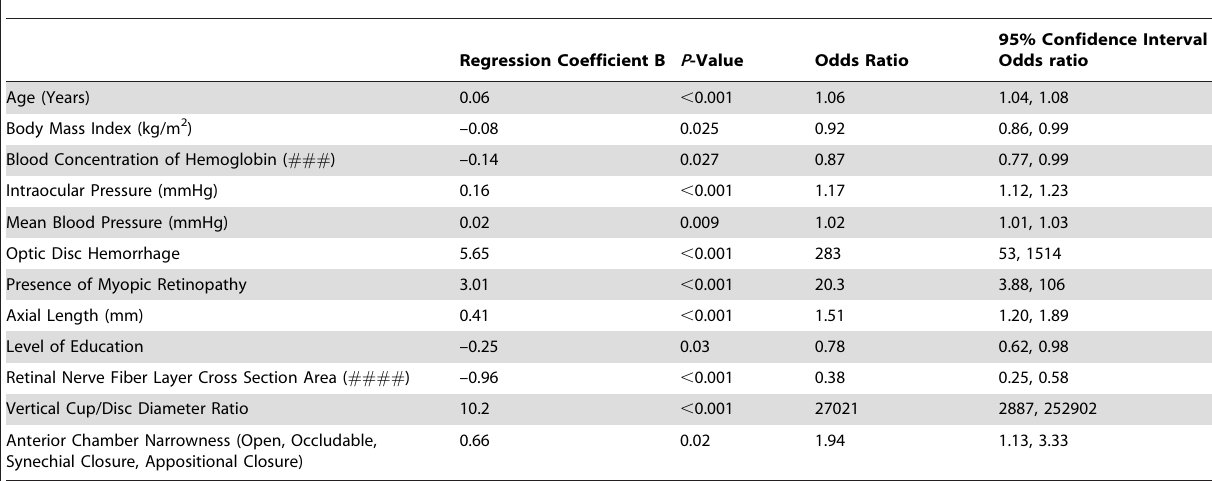
Table 1. Associations between the Prevalence of Glaucoma and Systemic and Ocular Parameters (Multivariable Analysis) in the Central India Eye and Medical